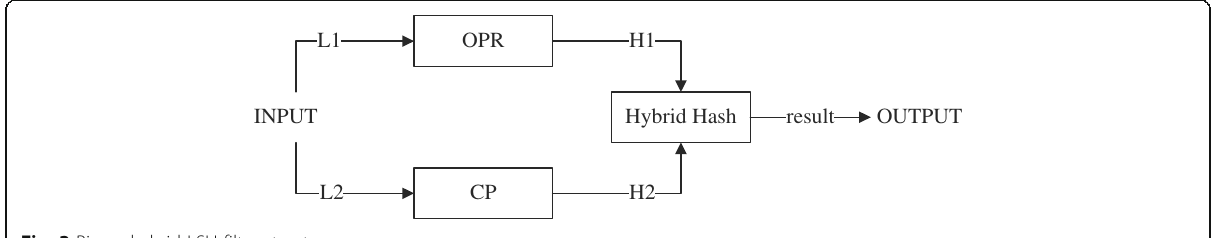
Fig. 3 Binary hybrid LSH filter